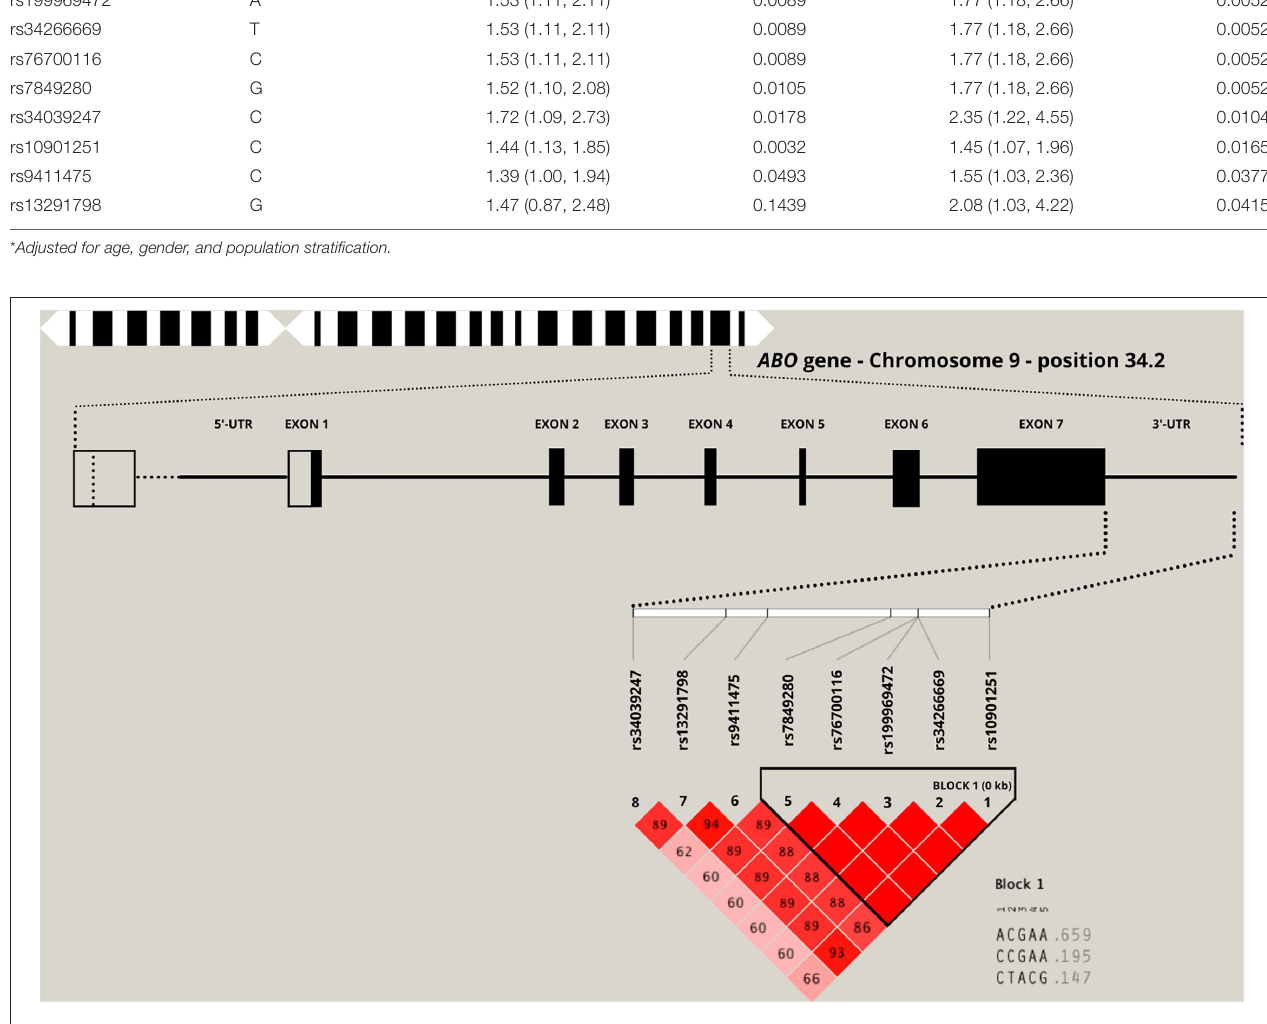
FIGURE 1 | Location of the top eight significant single nucleotide polymorphisms (SNPs) in the 3-untranslated region (3’-UTR) of the ABO candidate gene. The numbers inside each square and the square shading indicate the degree of linkage disequilibrium (LD) between SNPs (complete LD, D ′ = 1.0 and no LD, D ′ = 0.0).